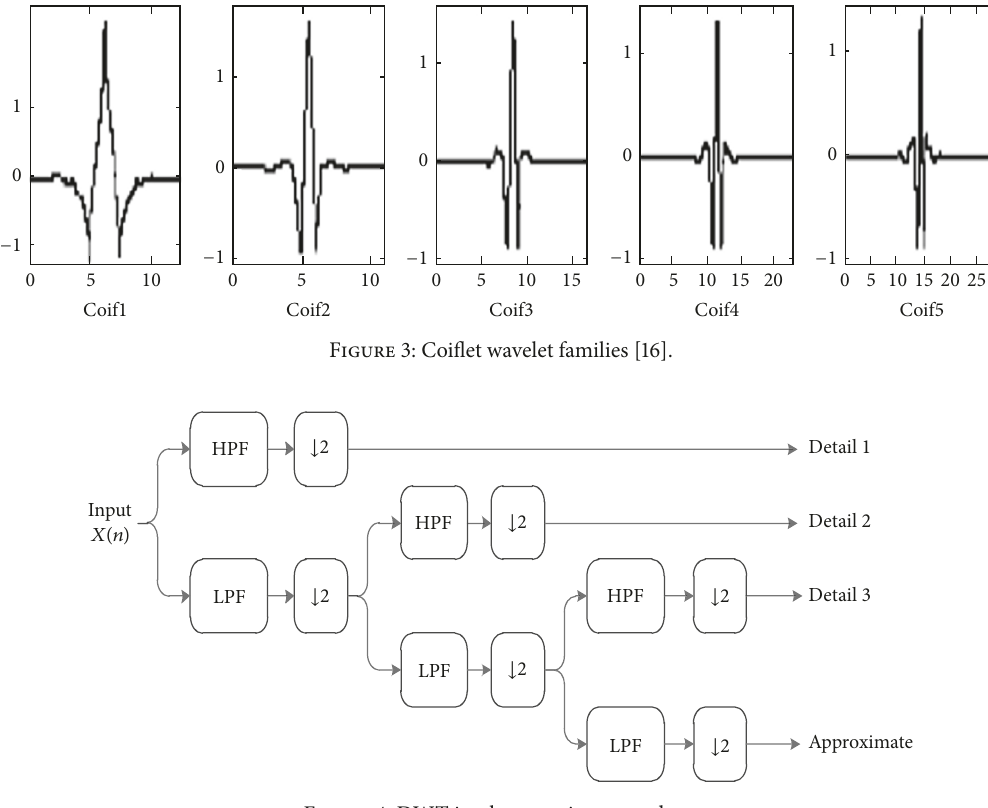
Figure 4: DWT implementation